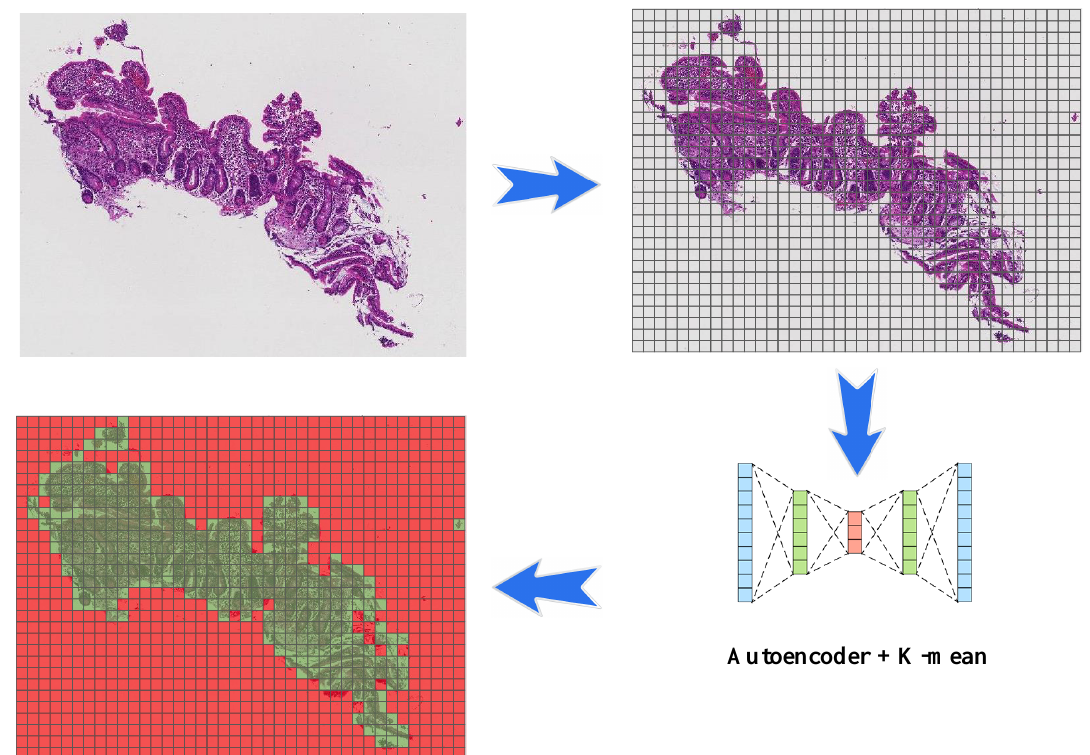
Figure 2. Pipeline of patching and applying an autoencoder to find useful patches for the training model. The biopsy images are very large, so we need to divide into smaller patches to be used in the machine learning model. As you can see in the image, many of these patches are empty. After using an autoencoder, we can apply a clustering algorithm to discard useless patches (green patches contain useful information, while red patches do